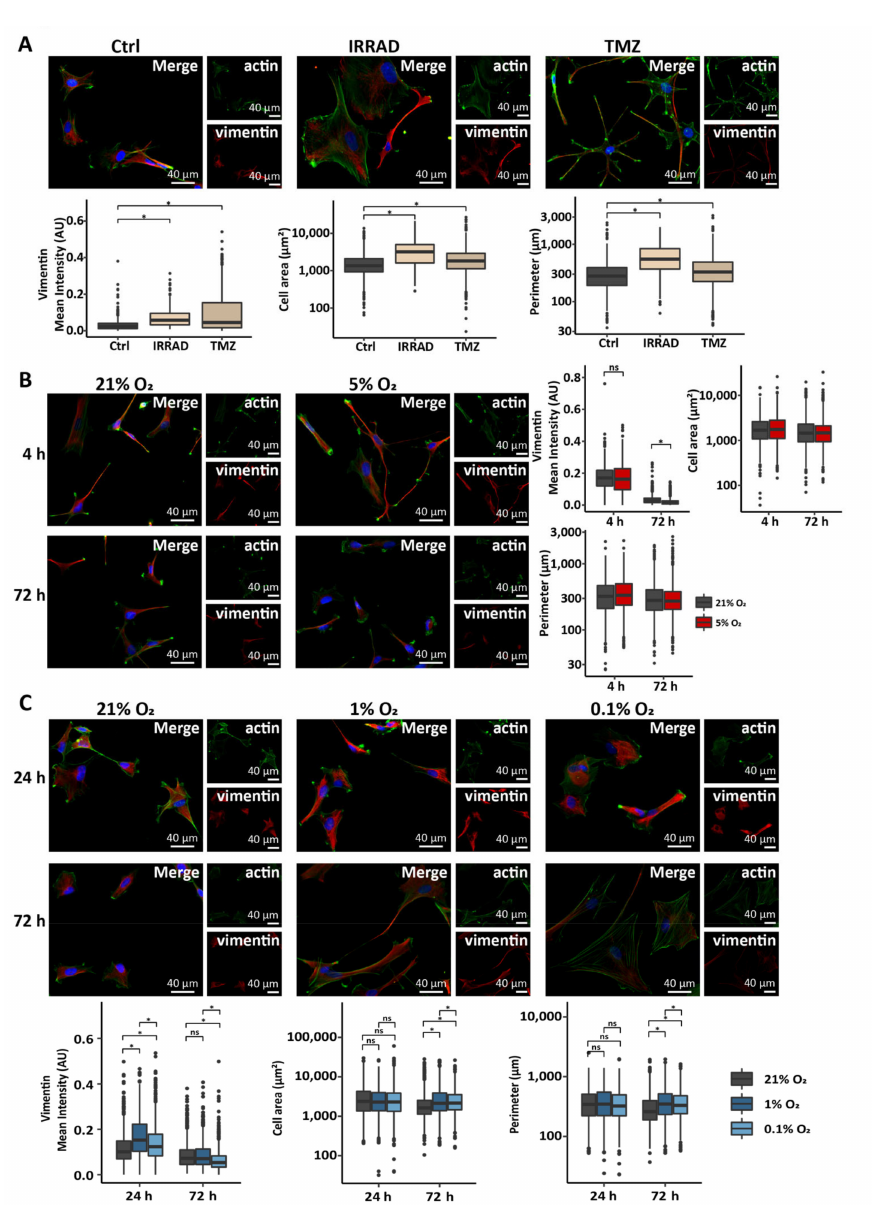
Figure 1. Astrocytes adopt a reactive phenotype in response to stress related to the glioma microenvi- ronment. ( A ) Representative images and quantification of vimentin fluorescence intensity, cell area, and cell perimeter in astrocytes after 72 h in culture after a single dose of 10 Gy (IRRAD) or treatment with 200 µ M temozolomide (TMZ) or DMSO (Ctrl). ( B ) Representative images and quantification of vimentin fluorescence intensity, cell area, and cell perimeter in astrocytes after 4 h or 72 h in culture at 21% or 5% O 2 . ( C ) Representative images and quantification of vimentin fluorescence intensity, cell area, and cell perimeter in astrocytes after 24 h or 72 h in culture at 21%, 1% or 0.1% O 2 . AU, arbitrary unit. Data represent one replicate from two (A) or three (B, C) independent astrocyte lines. * p ≤ 0.05; ns, not significant; one-way ANOVA or Welch’s ANOVA (post-hoc test: pairwise